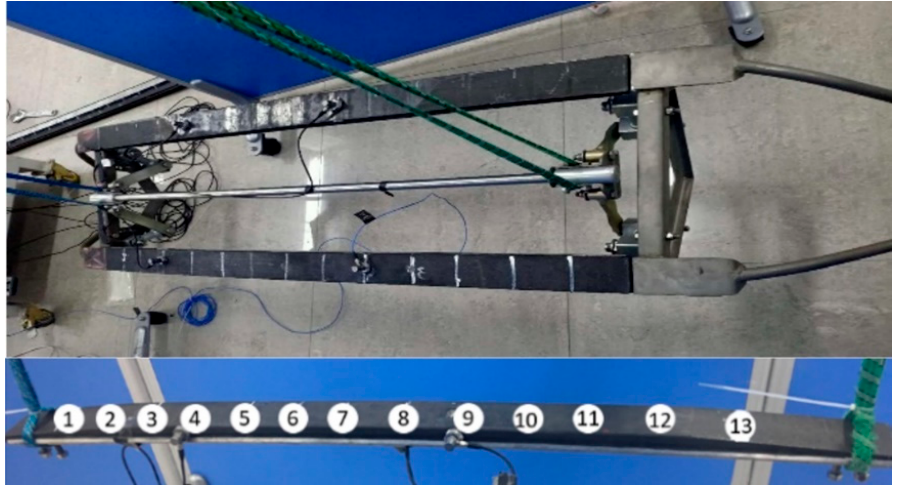
Figure 13. Modal test set-up for pantograph strips.